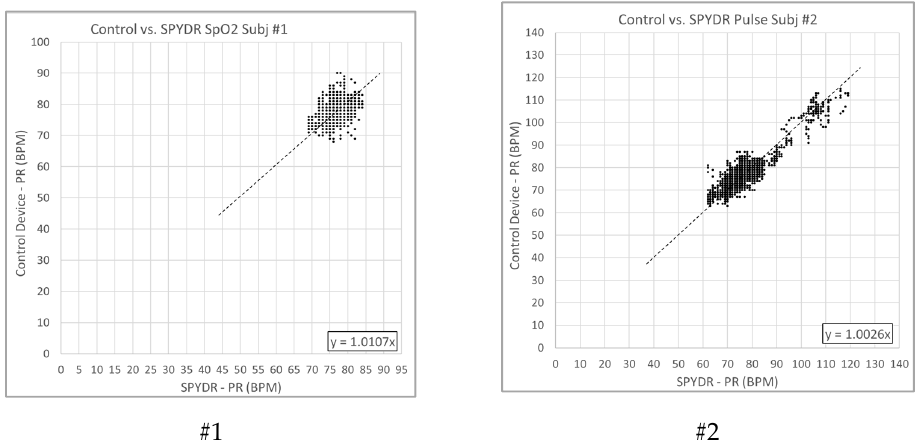
Figure 3. Correlation plot of Pulse Rate (PR) as determined by finger PPG sensor control vs. SPYDR for test #1 ( Left ) and test #2 ( Right ). Correlation coefficient by Pearson was 0.78 for test #1, 0.93 for test #2.